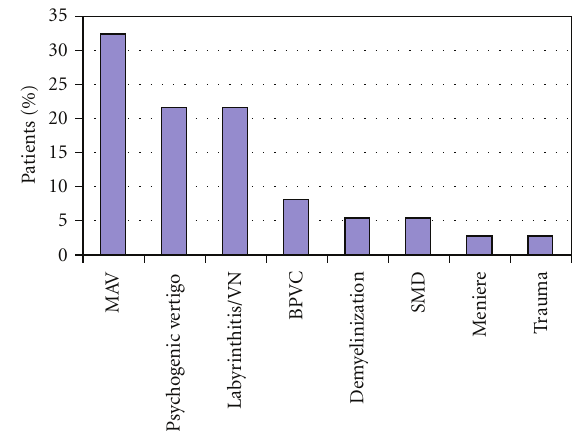
Figure 1: Distribution of the various etiologies for vertigo. MAV: migraine-associated vertigo, VN: vestibular neuritis, BPVC: benign paroxysmal vertigo of childhood, and SMD: space and motion dis-